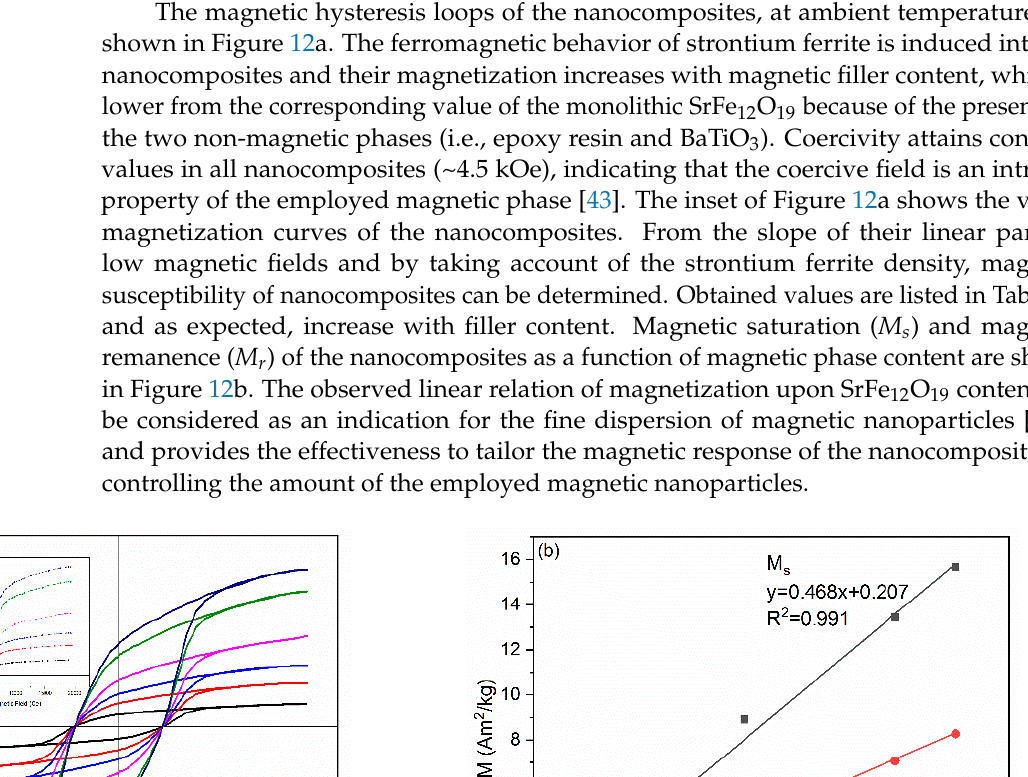
Figure 13. ( a ) Young’s modulus, tensile strength, and fracture toughness for all studied systems versus filler content. ( b ) Storage modulus and loss modulus (inset) as a function of temperature for all studied systems.